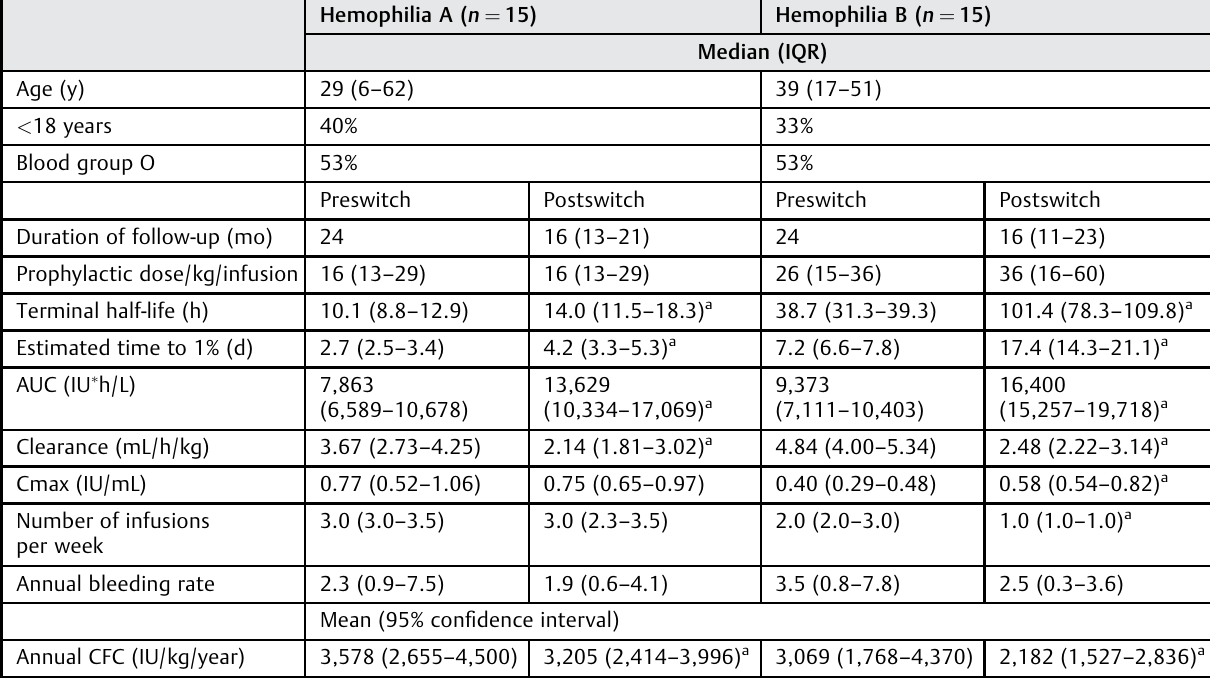
Table 1 Treatment characteristics and bleeding before and after switching to FVIII-Fc or FIX-Fc